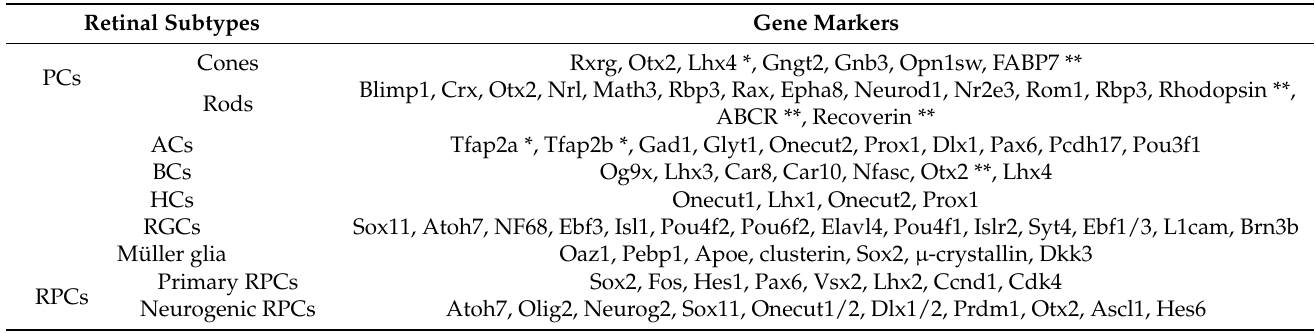
Table 1. Common gene markers of main retinal cells in